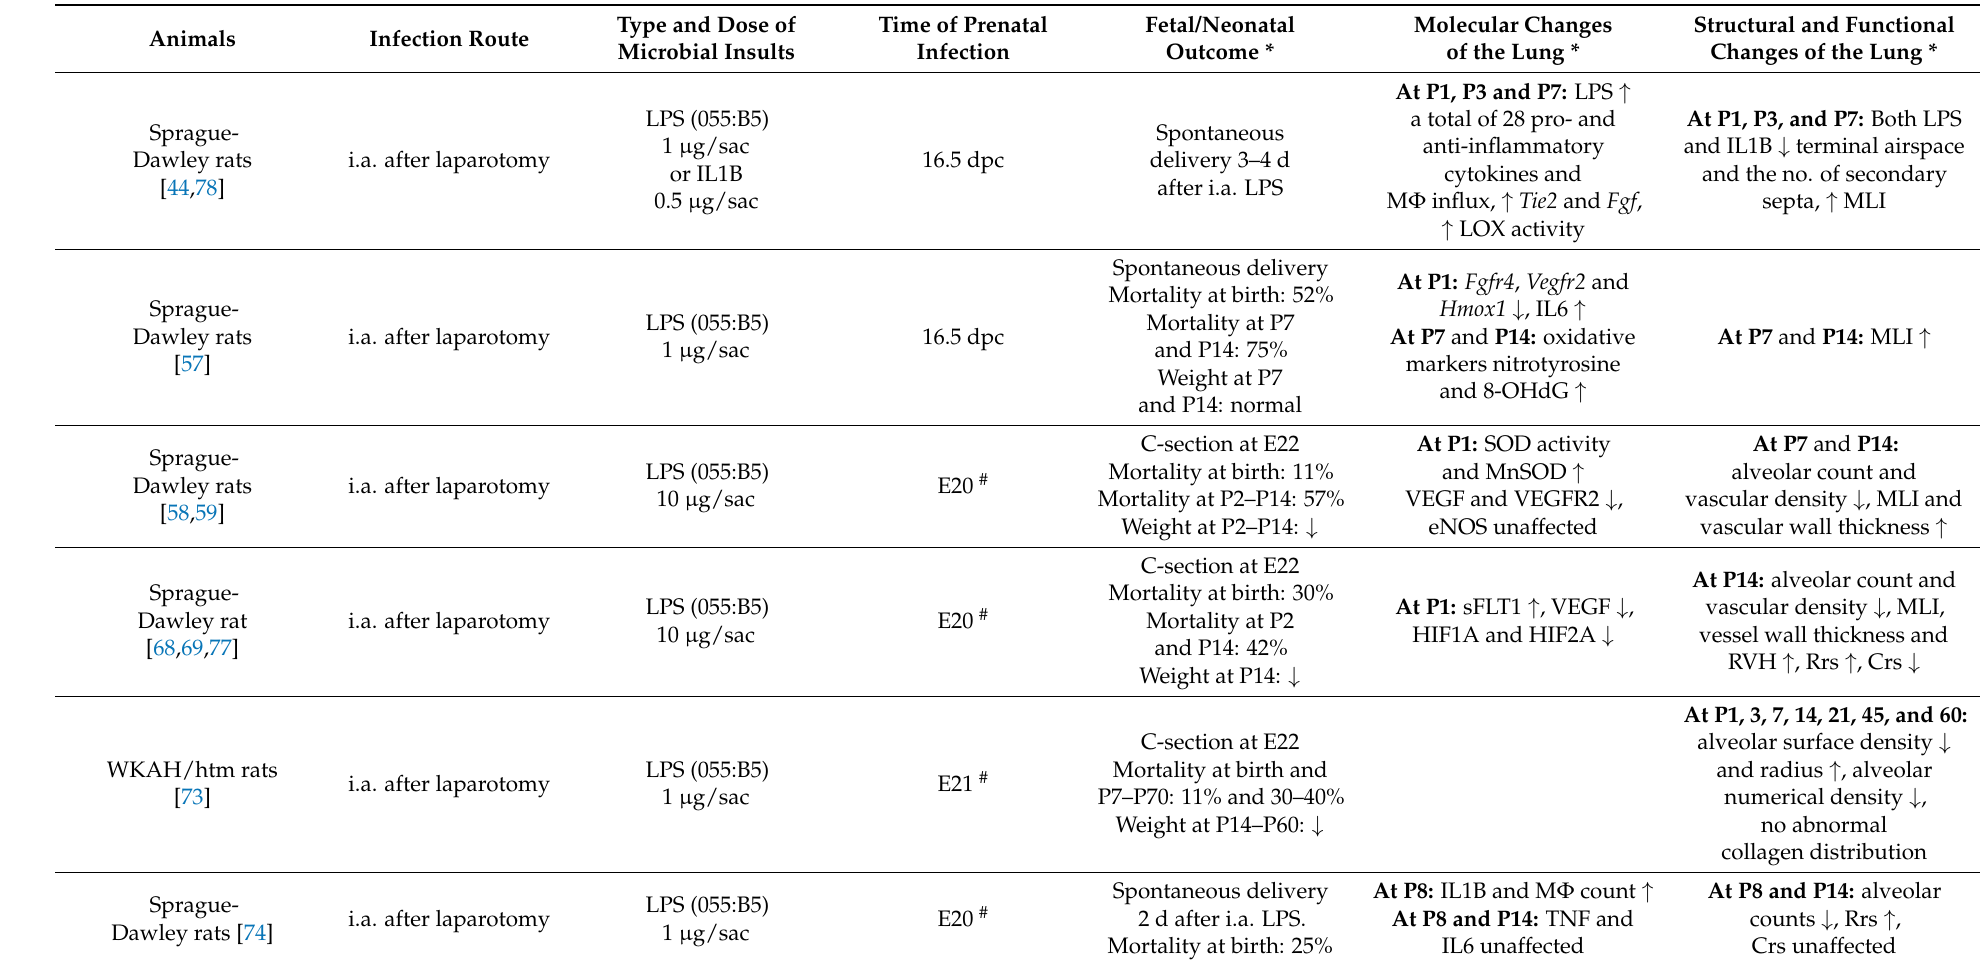
Table 1. A comprehensive list of rodent models of prenatal infection and pulmonary